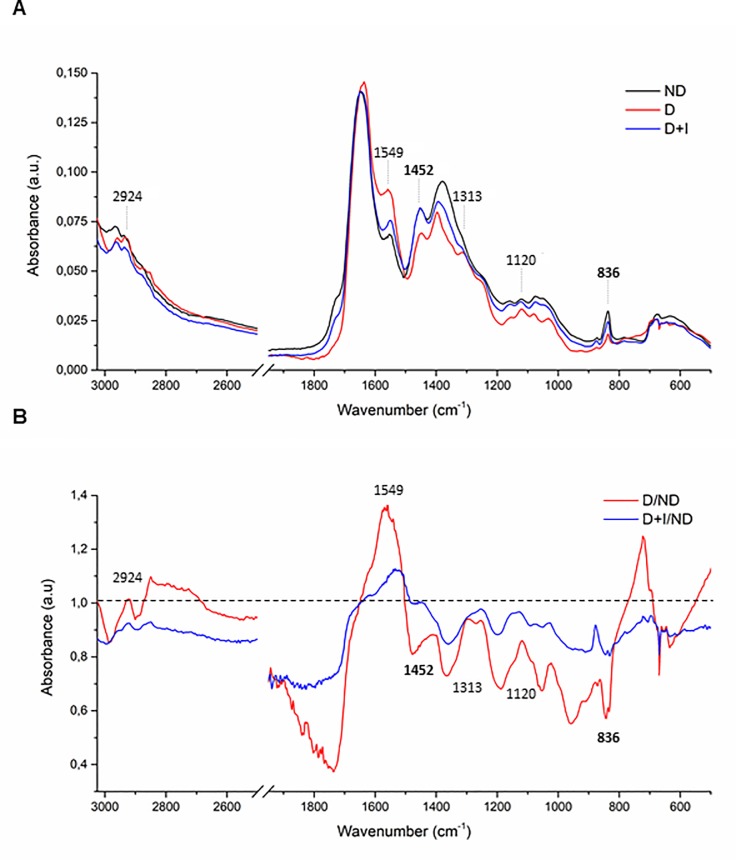
(A) Representative average ATR-FTIR spectra (3000–400 cm-1) in saliva of Non-Diabetic rats (ND), diabetic rats (D) and diabetic treated with insulin (D+I). (B) Representative spectral changes compared to ND rats.